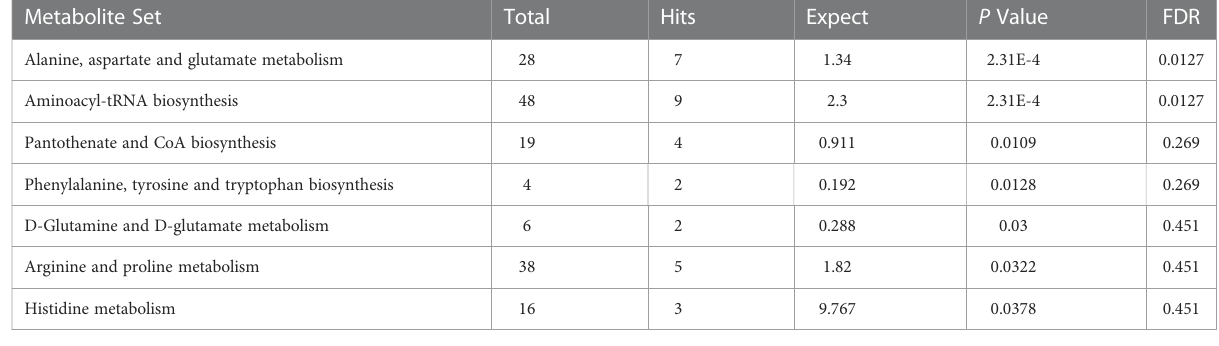
TABLE 1 Statistically signi fi cant metabolic pathways that differed between 1 mm cut margin tissue and cancer tissue identi fi ed by KEGG analysis. Metabolite Set Total Hits Expect